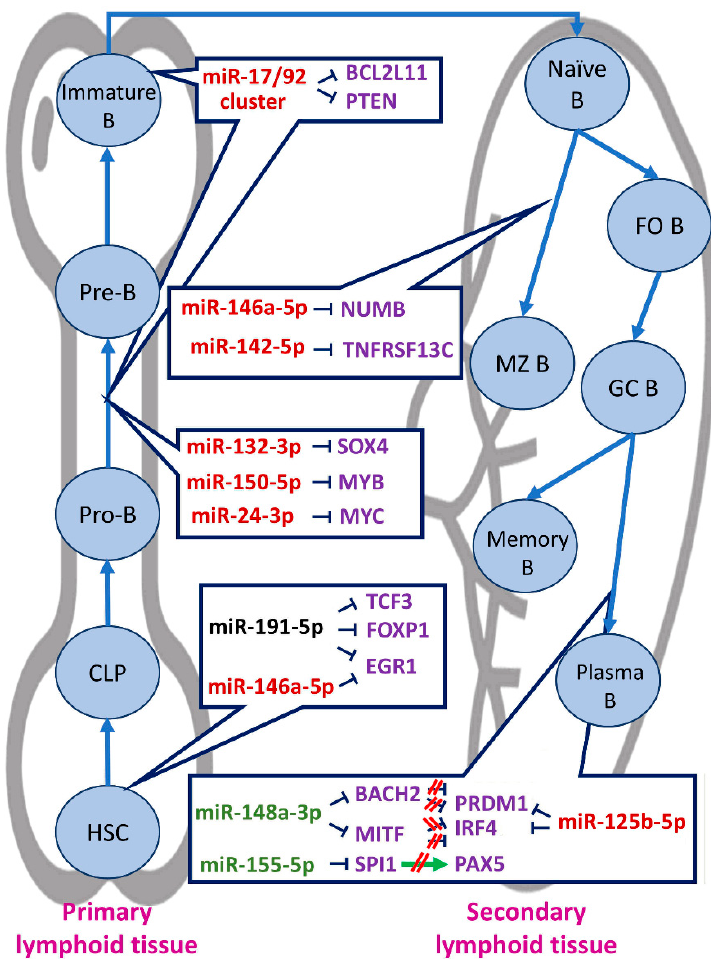
Figure 2. Brief illustration of B-cell development. miRNAs with a positive impact on the procedure are shown in green font, while those with a negative impact are shown in red. Black color indicates a miRNA with a controversial impact on B-cell development. miRNA targets are shown in purple font. Light blue arrows indicate the transition to the next developmental stage of B cells; dark blue “reverse tau” symbols ( ⊥ ) indicate attenuation of expression, whereas green arrows indicate induction of expression. Abbreviations: CLP, common lymphoid progenitor; FO B, follicular B cell; GC B, germinal center B cell; HSC, hematopoietic stem cell; MZ B, marginal zone B cell.